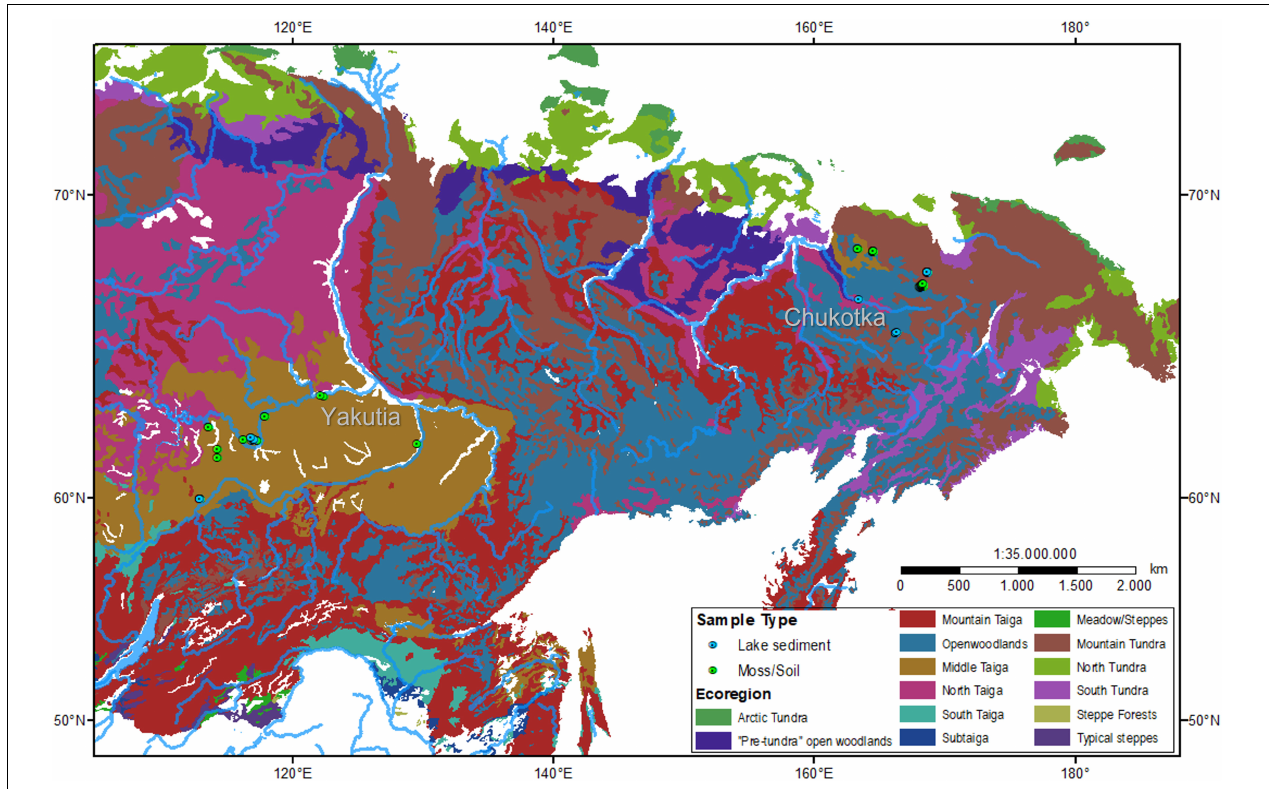
FIGURE 1 | Vegetation map (after Stone and Schlesinger, 2004) and locations of sampling sites in north-eastern and central Siberia.